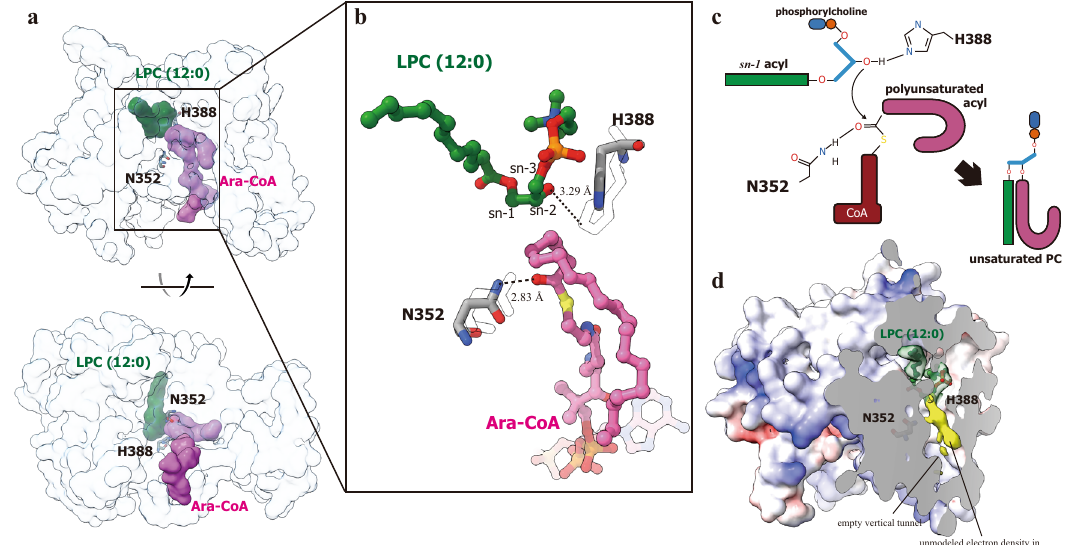
Fig. 4 The merged molecular model for cLPCAT3 in dual-substrates bound state. a The model of cLPCAT3/LPC protomer was superposed with the model of cLPCAT3/araCoA protomer which is shown in transparent blue surface for cLPCAT3 and pink surface for araCoA, and the LPC molecule was then shown as green surface at its corresponding position in cLPCAT3/araCoA to generate the merged molecular model. b A close view on the spatial organization of the two substrates of acyl transferring reaction, as well as the catalytic residues, H388 and N352. The residues H388 and N352 were shown in stick model with the corresponding residues in cLPCAT3/LPC model shown as transparent sticks. The araCoA and LPC molecules were shown as stick- and-ball models. c The putative mechanism for the acyl transferring by LPCAT3. d The unmodeled electron density revealed in the EM map of cLPCAT3/ LPC. The surface model of cLPCAT3/LPC was dissected to show the LPC electron density (in green) and unmodeled density (in yellow).